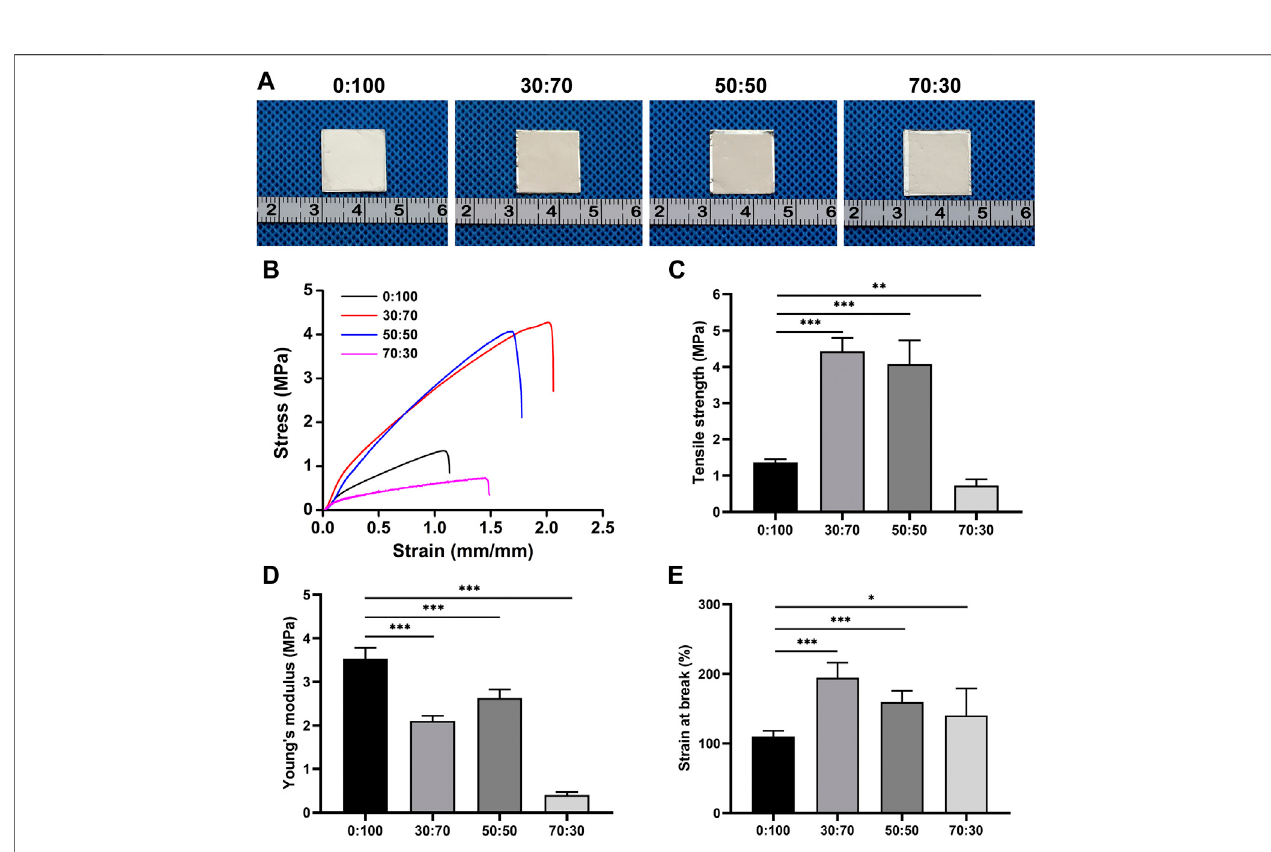
FIGURE3|(A) Gross views, (B) stress-strain curves, (C) tensilestrengths, (D) Young ’ smodulus,and (E) strains at break ofmembranes after 24-himmersion into physiological saline at 37 ° C (* p < 0.05; ** p < 0.01; *** p <